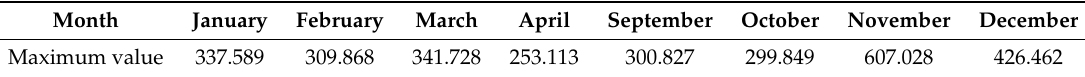
Table 1. The maximum values for data correction of NPP-VIIRS NTL data in